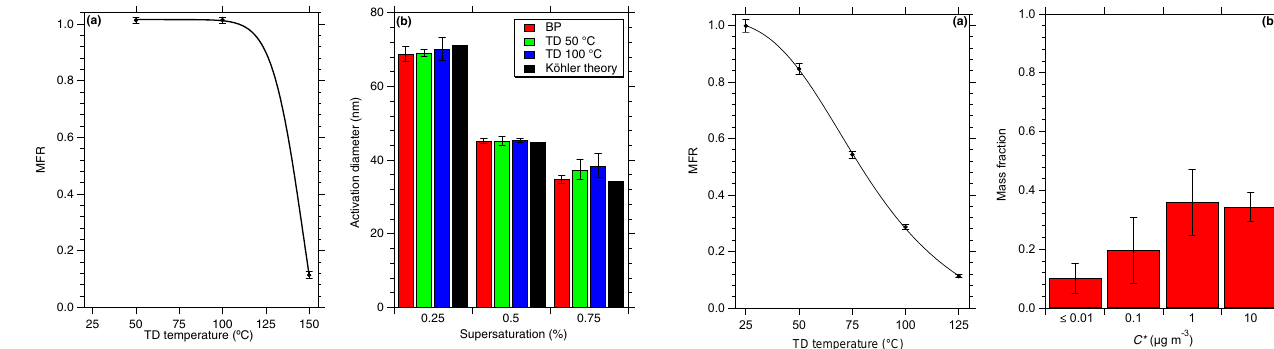
Figure 3. (a) Thermogram, corrected for losses in the TD, for Ex- periment 1 with the fit from the TD model (Riipinen et al., 2010; Karnezi et al., 2014). The error bars represent 1 standard deviation of the mean. (b) SOA volatility distribution for Experiment 1 us- ing the 1D-VBS framework (Donahue et al., 2006). The error bars correspond to 1 standard deviation of the solution calculated by the